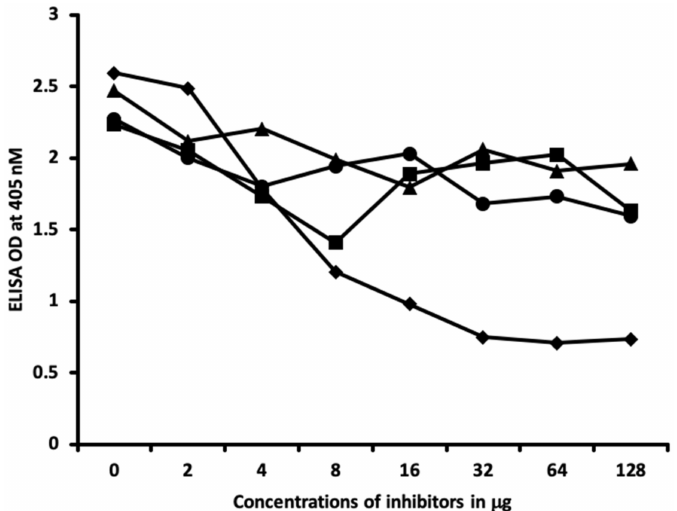
Figure 10. Binding of thyroglobulin antibody to aflatoxin-HSA in the absence or presence of aflatoxin-HSA, formaldehyde-HSA, BPA-HSA, and parabens-HSA in concentrations of 0, 2, 4, 8, 16, 32, 64, and 128 µ g / mL. (cid:7) = Aflatoxin-HSA; (cid:4) = formaldehyde-HSA; (cid:78) = BPA-HSA; • =